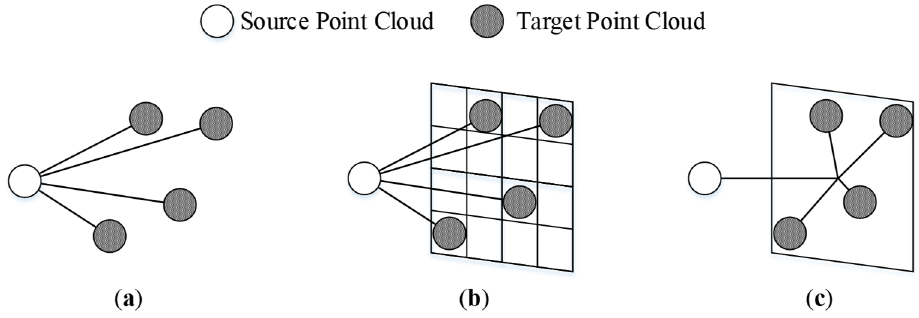
Figure 3. Comparison of point cloud registration strategies. ( a ) ICP/GICP; ( b ) NDT; ( c ) our algo- rithm.